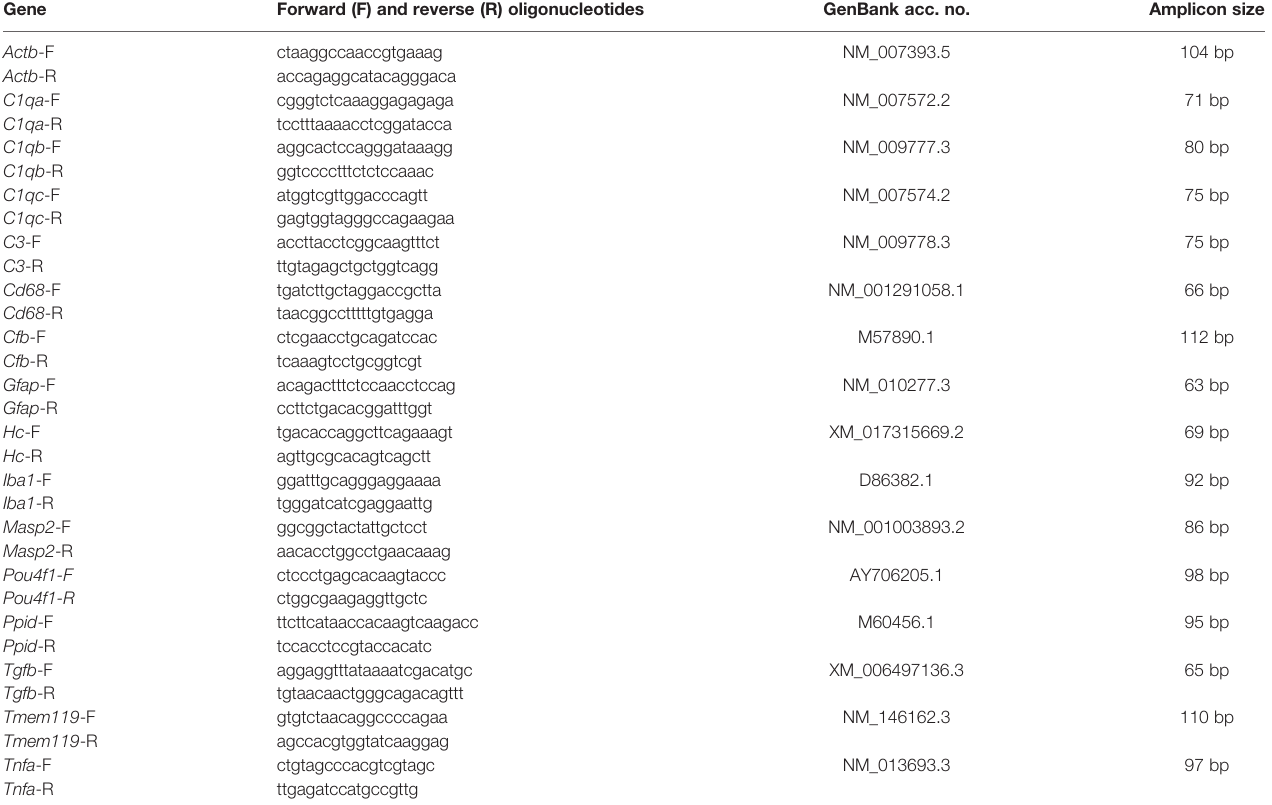
TABLE 2 | Primer pairs for RT-qPCR analysis. Gene Forward (F) and reverse (R) oligonucleotides GenBank acc.